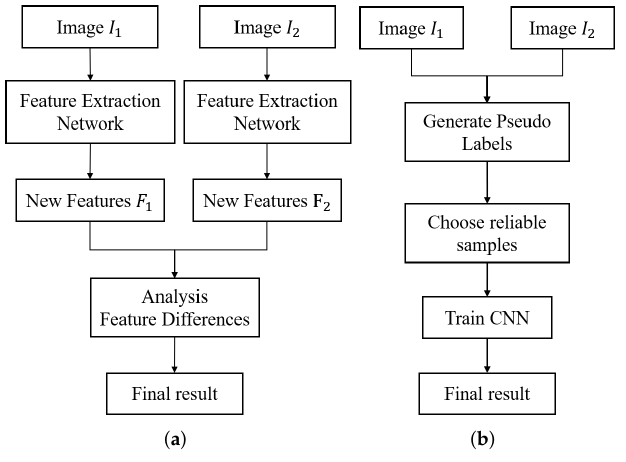
Figure 1. Architectures of two unsupervised deep methods for change detection. ( a ) Feature analysis- driven model training. ( b ) Pseudo-labels-driven model